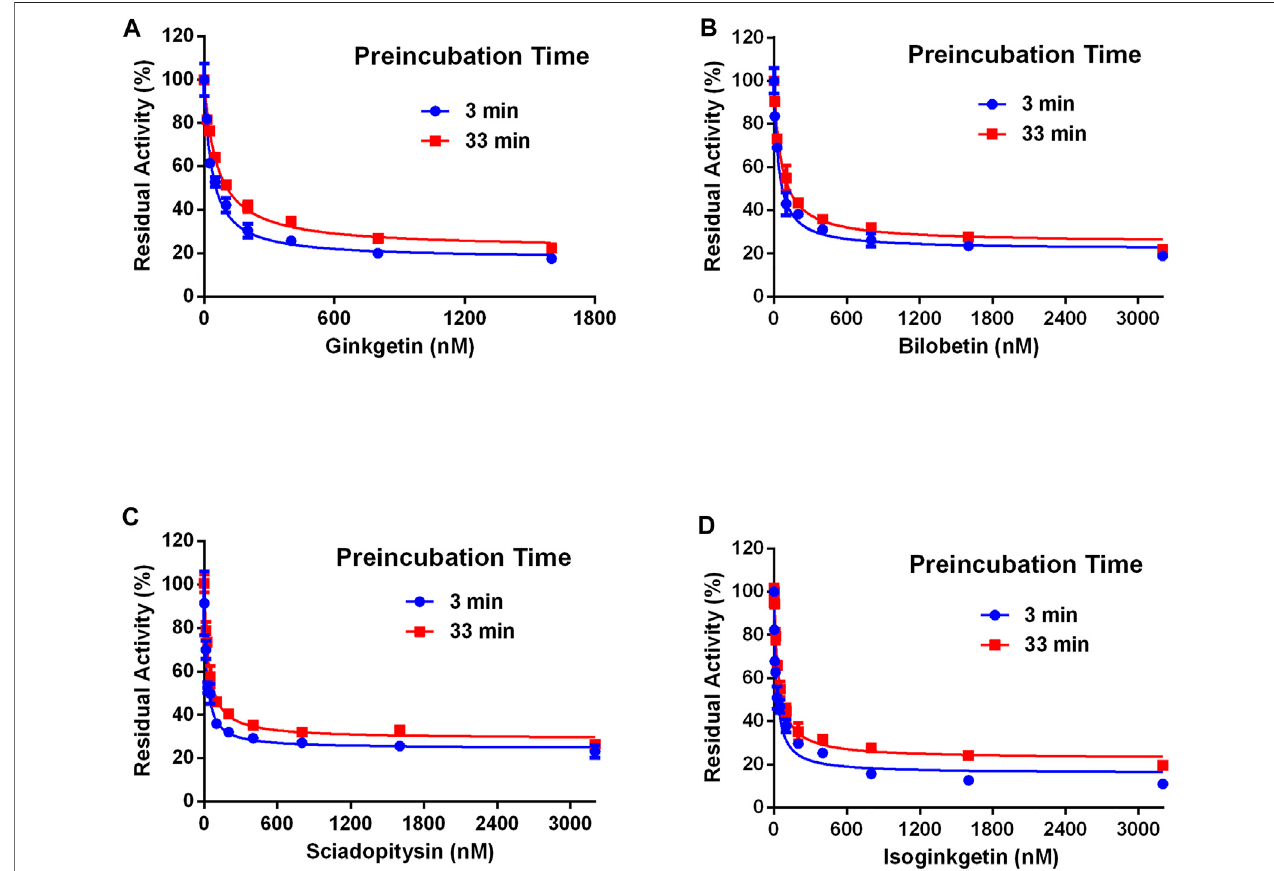
FIGURE 7 | The residual activity of CES2-catalyzed hydrolysis of FD in the presence of different concentrations of bi fl avones from Ginkgo biloba at different pre- incubation times of 3 and 33 min. All data were shown as mean ± SD of triplicate assays.